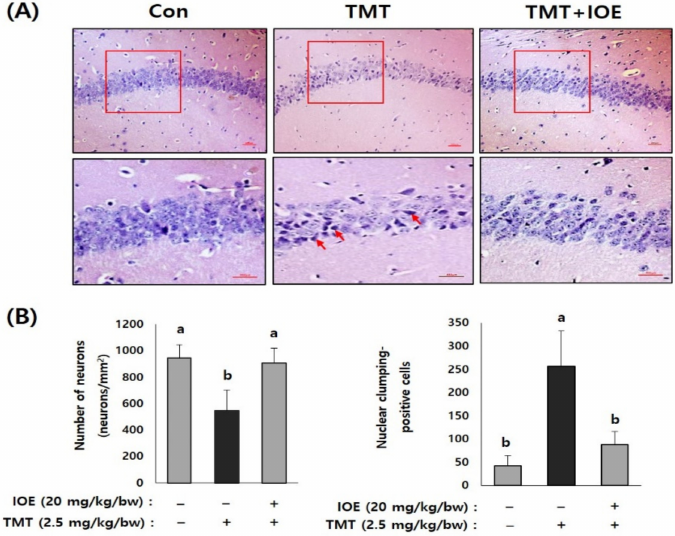
Figure 4. IOE attenuated TMT-induced neuronal loss in mouse brains. Representative CA1 subfield of the hippocampal region of a mouse brain stained with hematoxylin–eosin (H&E) ( A ). Enlarged area of the square in the upper panels is shown in the lower panel ( A ) and the number of vi- able cell and pyknotic nuclei was counted and tabulated ( n = 5) ( B ). Arrow indicates pyknotic nuclei. Data are expressed as the means ± SD. Con: control (non-treated). a: significant differences ( p < 0.05) when compared with b ( n = 5). Magnification 200 × (upper panel) and 400 × (lower panel). Scale bar = 50 µ